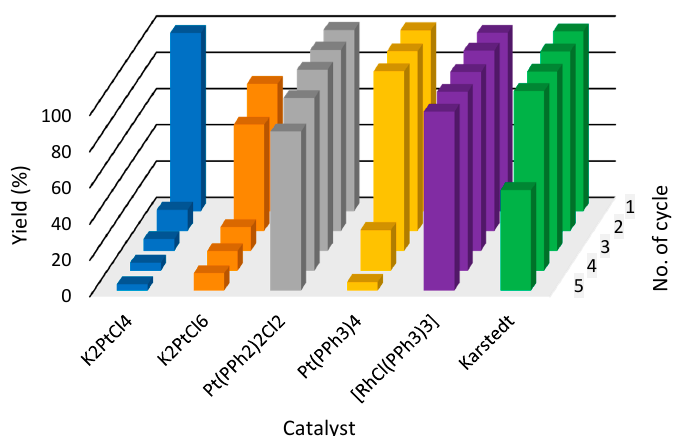
Figure 3. The yields of hydrosilylation reaction carried out in [P 44414 ][NTf 2 ] ( 1 ) (tributyltetradecylphosphonium bis(trifluoromethylsulfonyl)imide) in subsequent cycles. Colors refer to different catalysts used in hydrosilylation reaction.